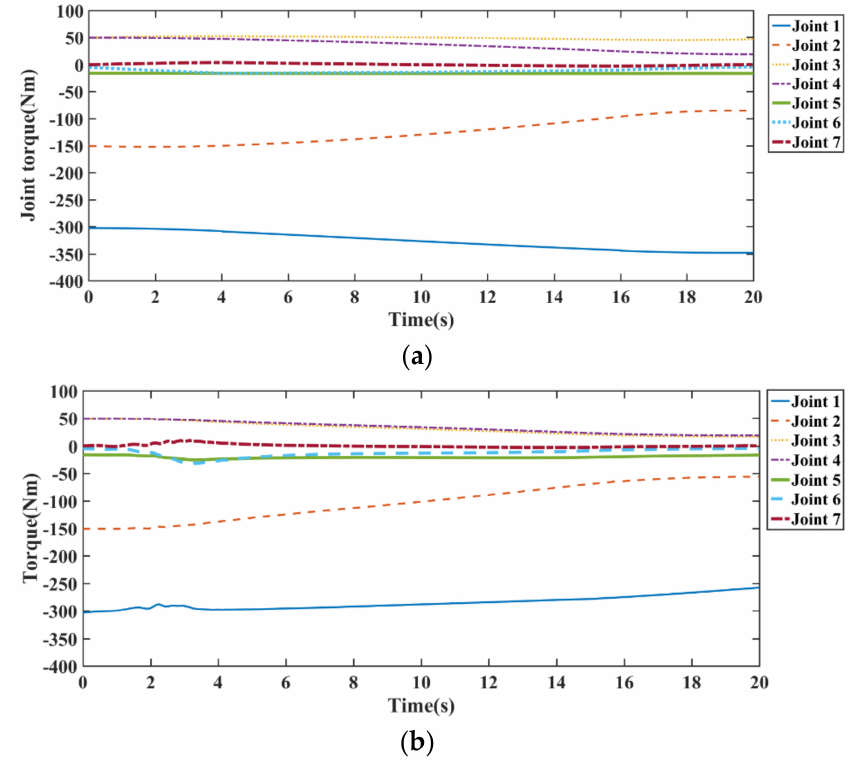
Figure 23. Joint torque of trajectories. ( a ) Without optimization, ( b ) With optimization.